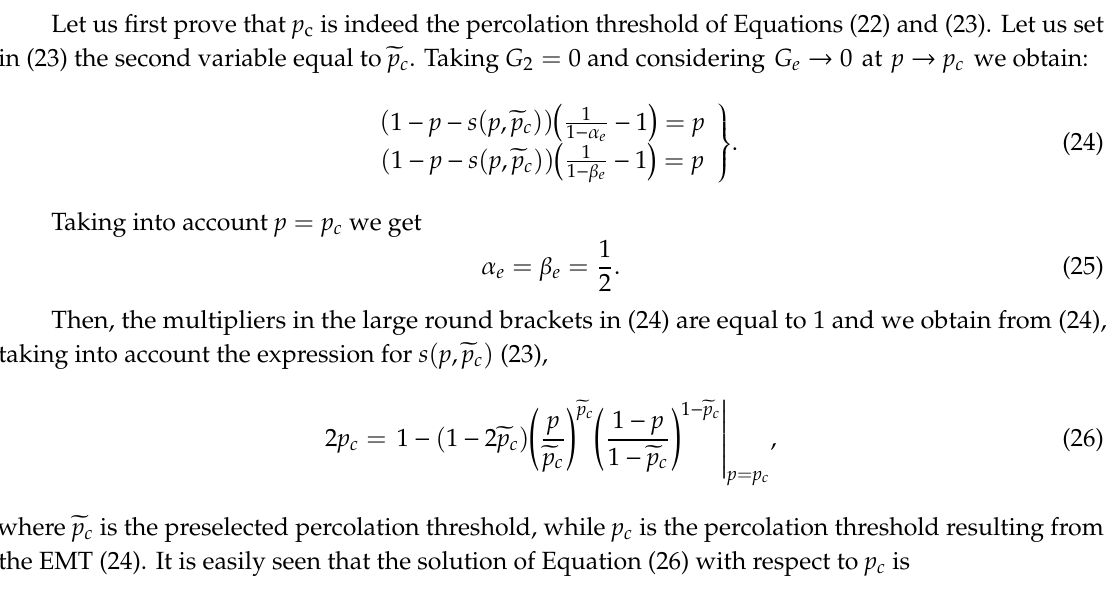
Figure 5. Concentration dependence of the normalized e ff ective shear modulus G e / G of the percolation threshold. G 1 = 10 11 Pa, ν 1 = 0.3, G 2 = 10 5 Pa, ν 2 =